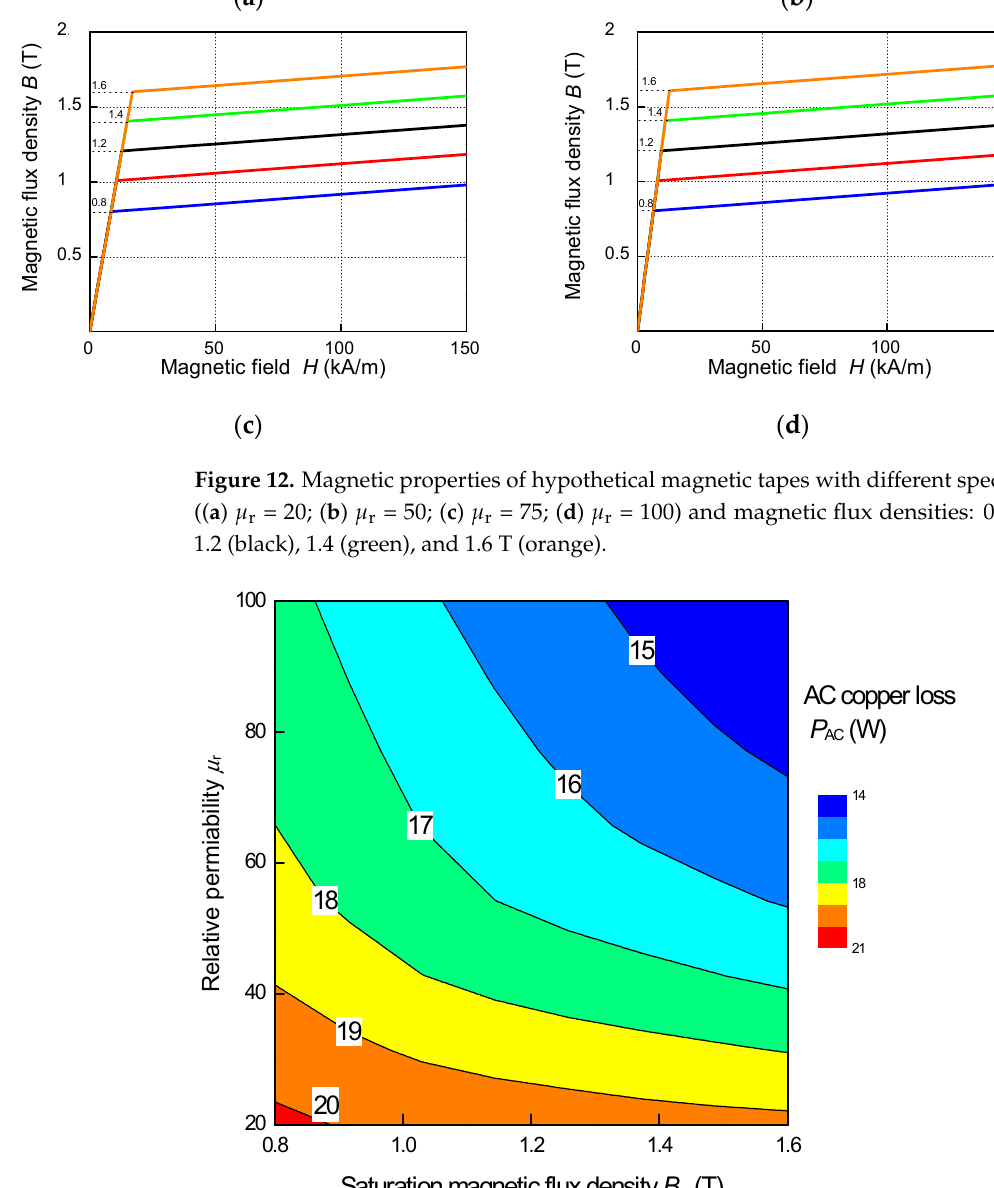
Figure 12. Magnetic properties of hypothetical magnetic tapes with different specific permeabilities (( a ) μ r = 20; ( b ) μ r = 50; ( c ) μ r = 75; ( d ) μ r = 100) and magnetic flux densities: 0.8 (blue), 1.0 (red), 1.2 (black), 1.4 (green), and 1.6 T (orange).